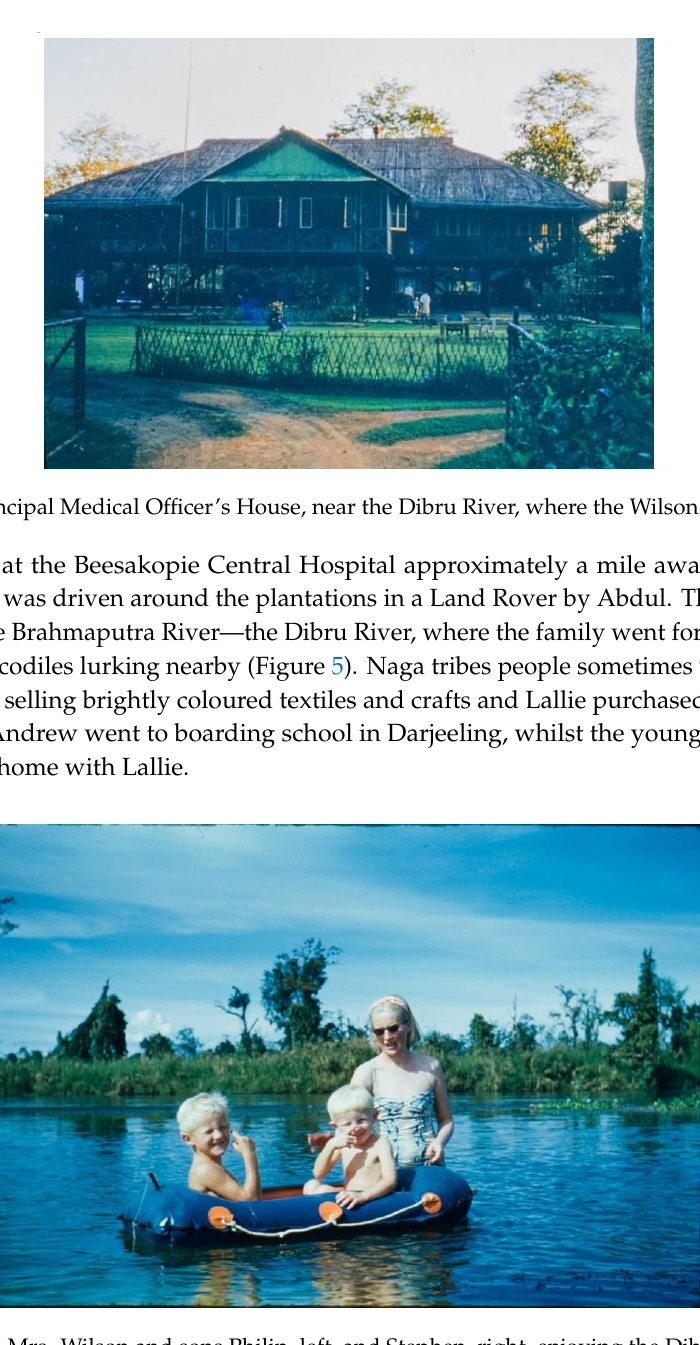
Figure 5. Mrs. Wilson and sons Philip, left, and Stephen, right, enjoying the Dibru